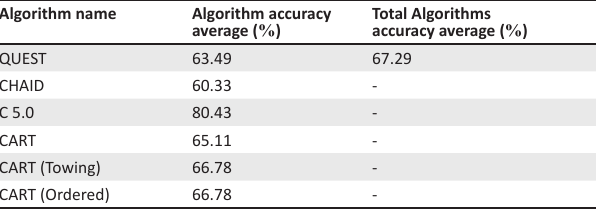
TABLE 3: Algorithms accuracy from 185 perquisite